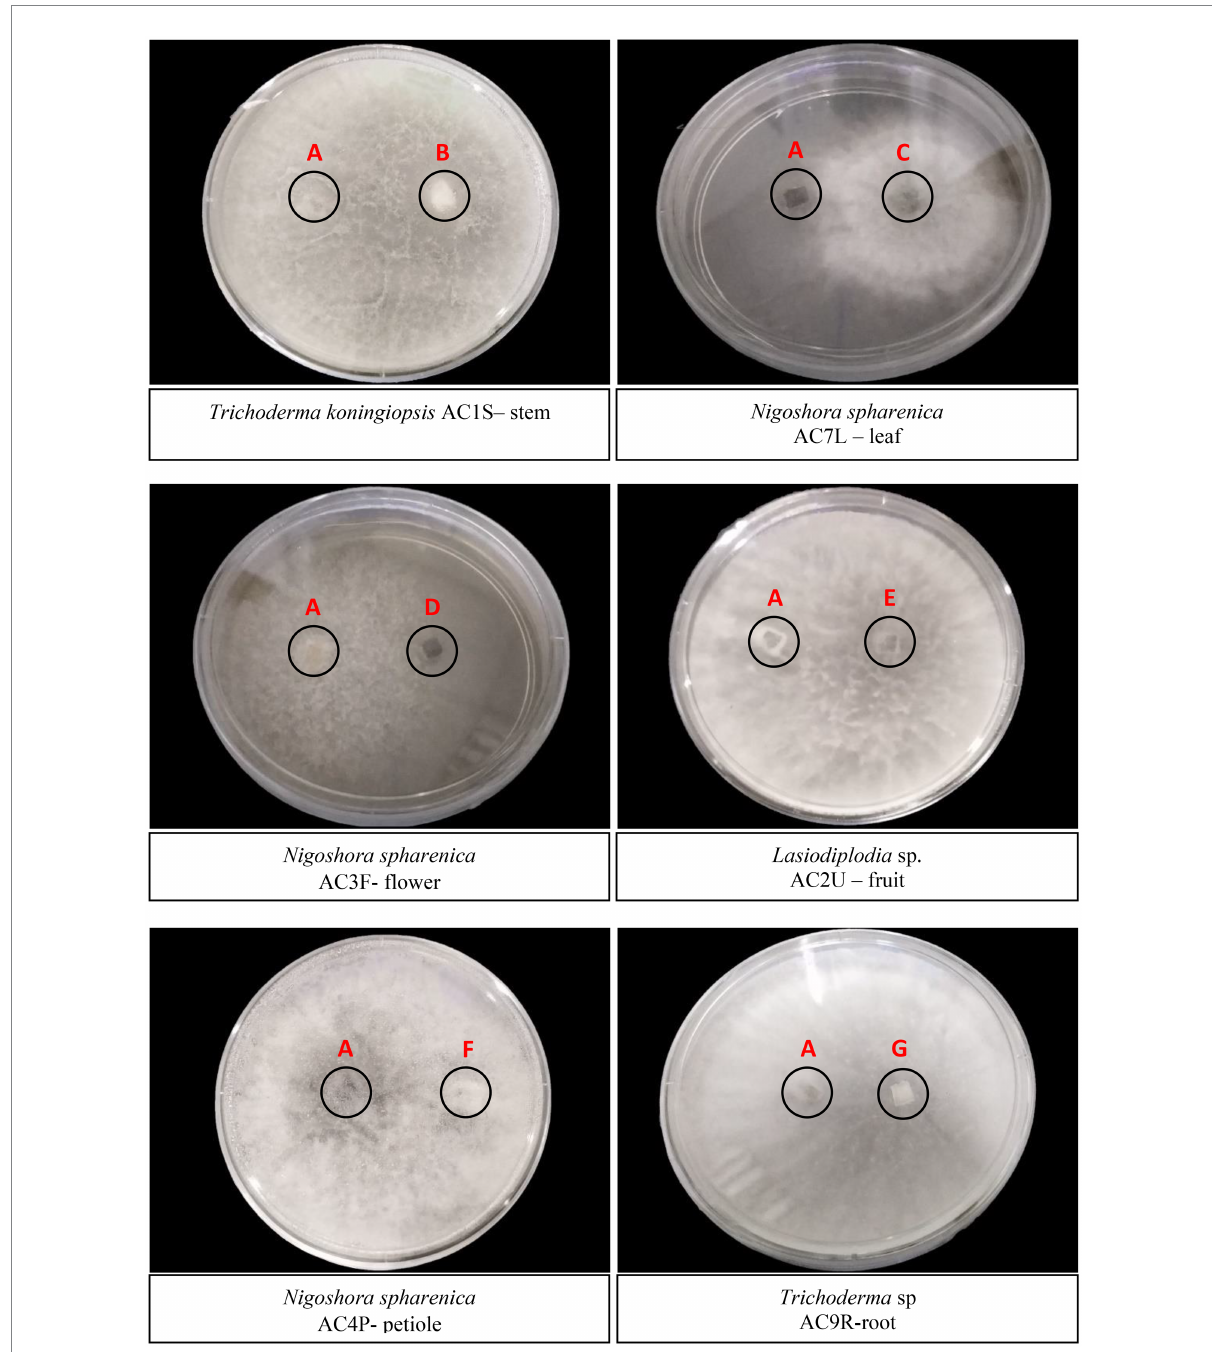
FIGURE 2 Dual culture plate assay between six endophytic fungal isolates against the pathogen C. fimbriata (A). (B) Trichoderma koningiopsis AC1S – stem; (C) Nigoshora spharenica AC7L – leaf; (D) Nigoshora spharenica AC3F - flower; (E) Lasiodiplodia sp. AC2U – fruit; (F) Nigoshora spharenica AC4P- petiole; (G) Trichoderma sp. AC9R-root. The plates were cultivated for 5 days at 27 ° C. Radial growths were measured and interaction were